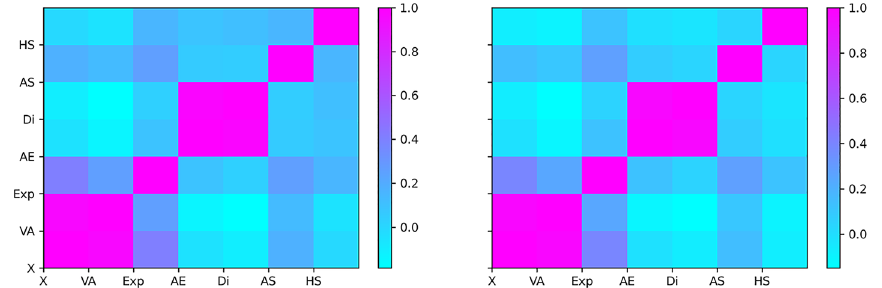
Fig. 5 Correlation matrix between macroeconomic variables and network properties. 2008 left and 2012 right. Each row (and column) is one variable. In axes one reads ’X’ for production, ’VA’ for value‑added, ’Exp’ for exports, ’AE’ for aggregate effect, ’Di’ for diffusion index, ’AS’ for authority score, and ’HS’ for hub score. Each cell is the Spearman correlation coefficient between pair of variables given by the color map. This figure was generated by authors based on INEGI data using Python 3.6 and Python libraries scipy, numpy, networkX, and matplotlib. Source: Visualizations made by authors based on authors